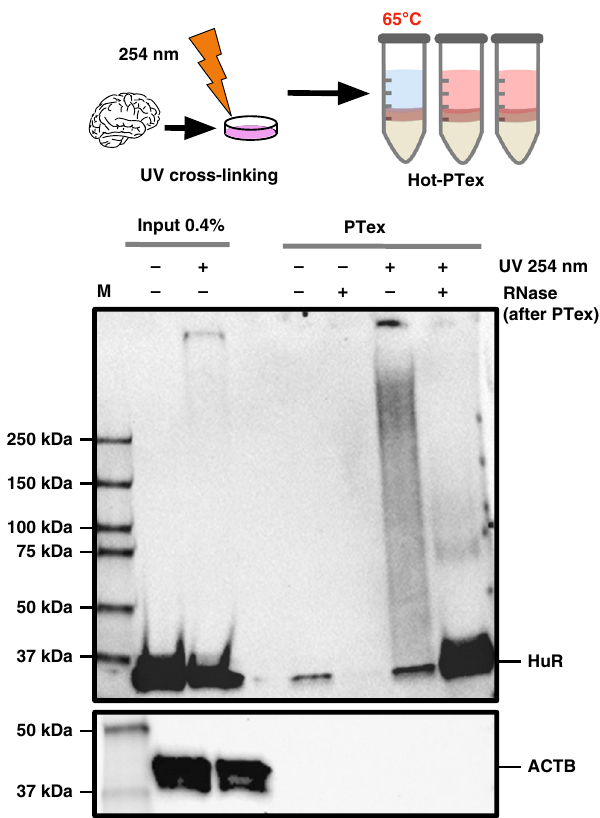
Fig. 3 RNP puri fi cation from animal tissue. Mouse brain tissue was cryo- grinded and UV-irradiated before (Hot)-PTex was performed. Western blot against HuR (ELAVL1) demonstrates recovery of cross-linked HuR from mouse tissue while beta-actin (ACTB) is ef fi ciently depleted. For full blots see Supplementary Figure